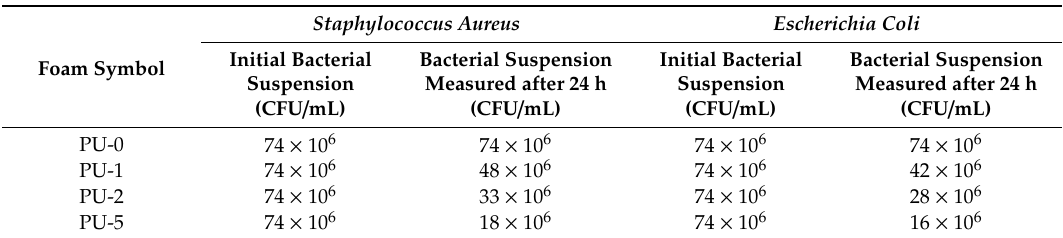
Table 6. Microbial properties of PU composite foams against Staphylococcus aureus and Escherichia coli . Staphylococcus Aureus Foam Symbol